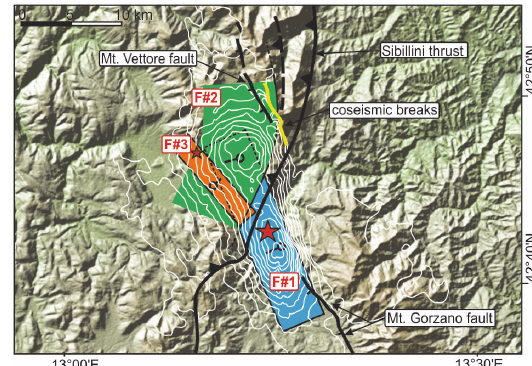
(Emergeo Working Group, 2016). Thin, black and yellow lines are presumed active faults from Galadini and Galli (2003). A thick, black line shows the trace of the Sibillini Thrust. Colored boxes (blue, green and orange) show the simplified surface pro- jection of the three main faults that participated in the earth- quake sequence. The pattern of elevation changes detected by ALOS-2 is shown in